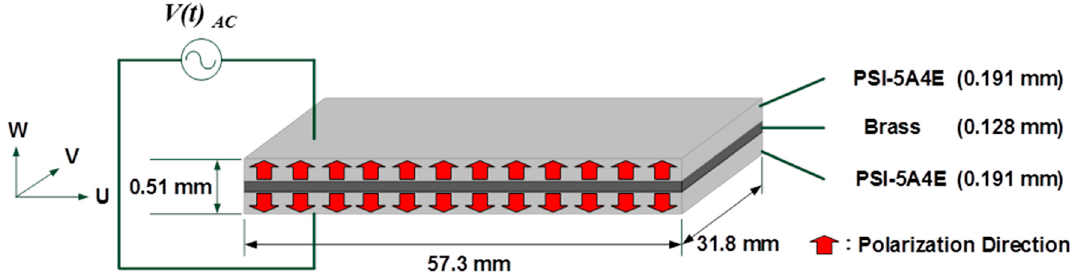
Figure 2. Thickness and construction of the PVEH plate.